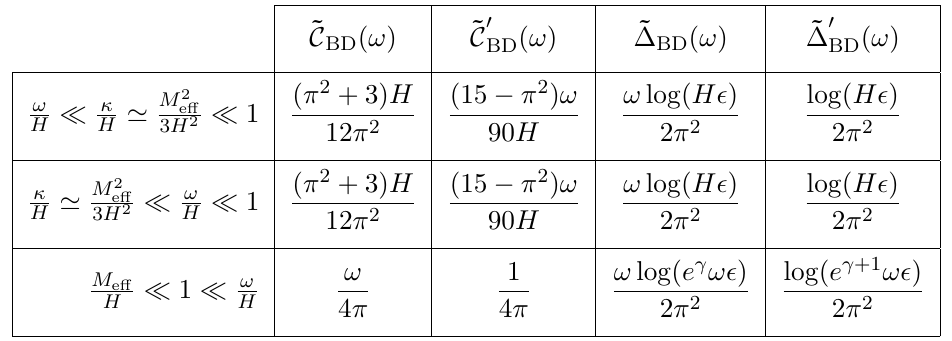
0 0 , ~ (cid:1) BD and ~ (cid:1) in various regimes of BD BD